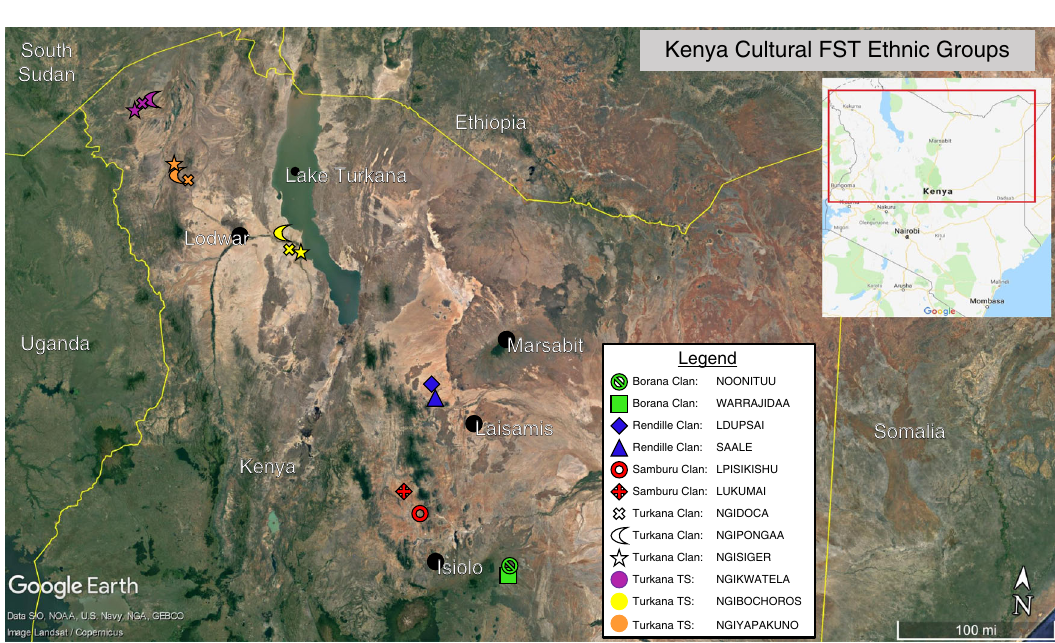
Fig. 1 Data collection sites. GPS locations of the clans and territorial sections in the sample superimposed on Google Earth map of northern Kenya. TS, territorial